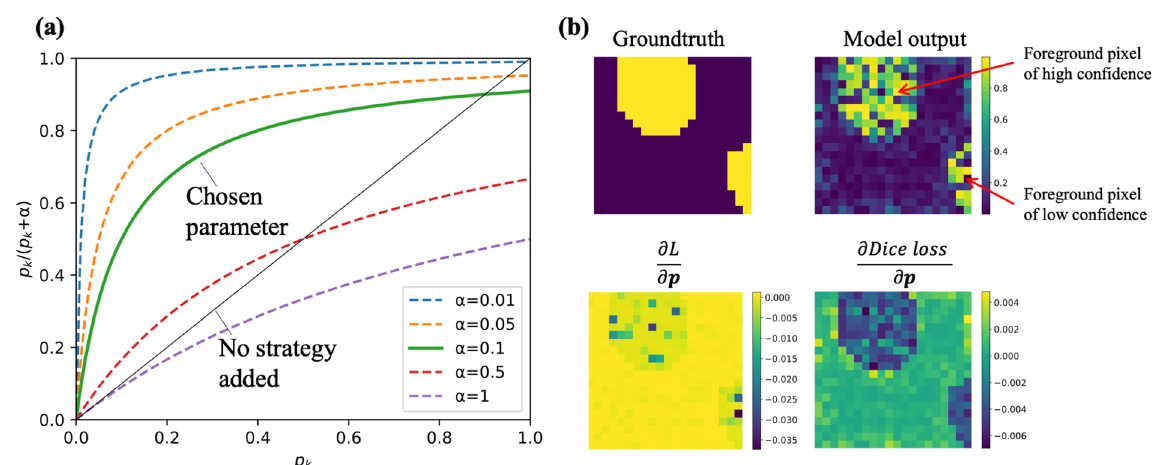
Figure 5. Addressing the clumped cell problem using 3DCellSeg Loss. [ Note ( a ) p k p shows how different α affects the replacement p